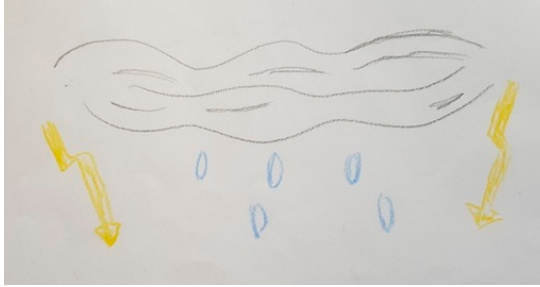
Figure 6. P40’s perception of PD.